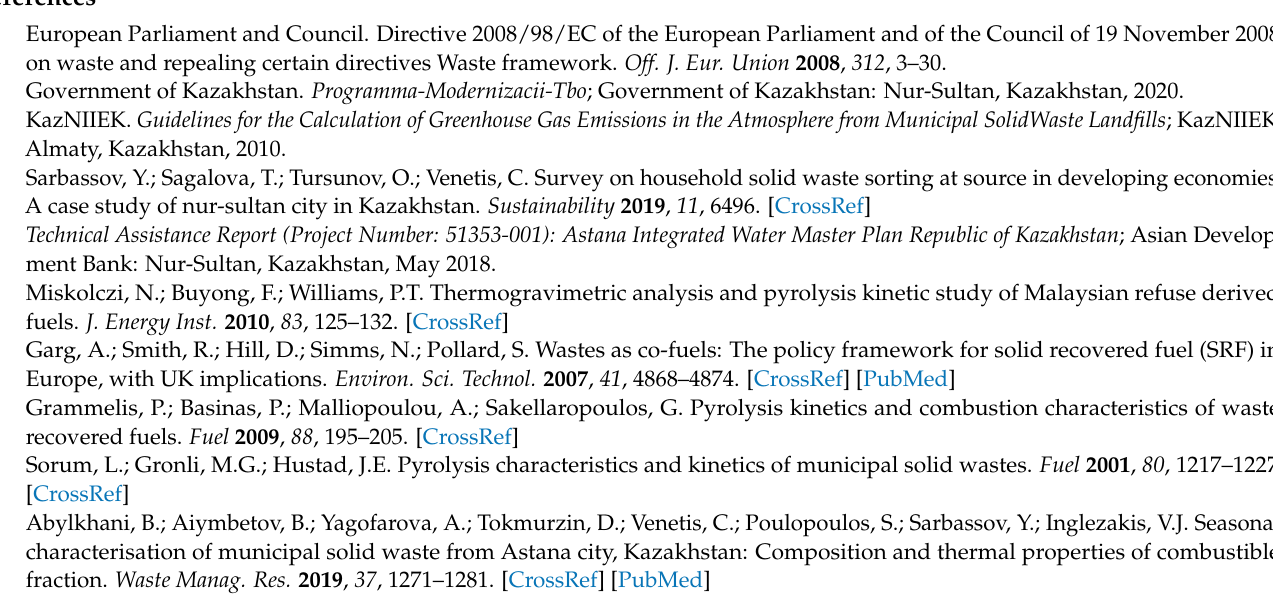
by FWO; Table S2: Kinetic parameters of textile fraction by FWO; Table S3: Kinetic parameters for paper by